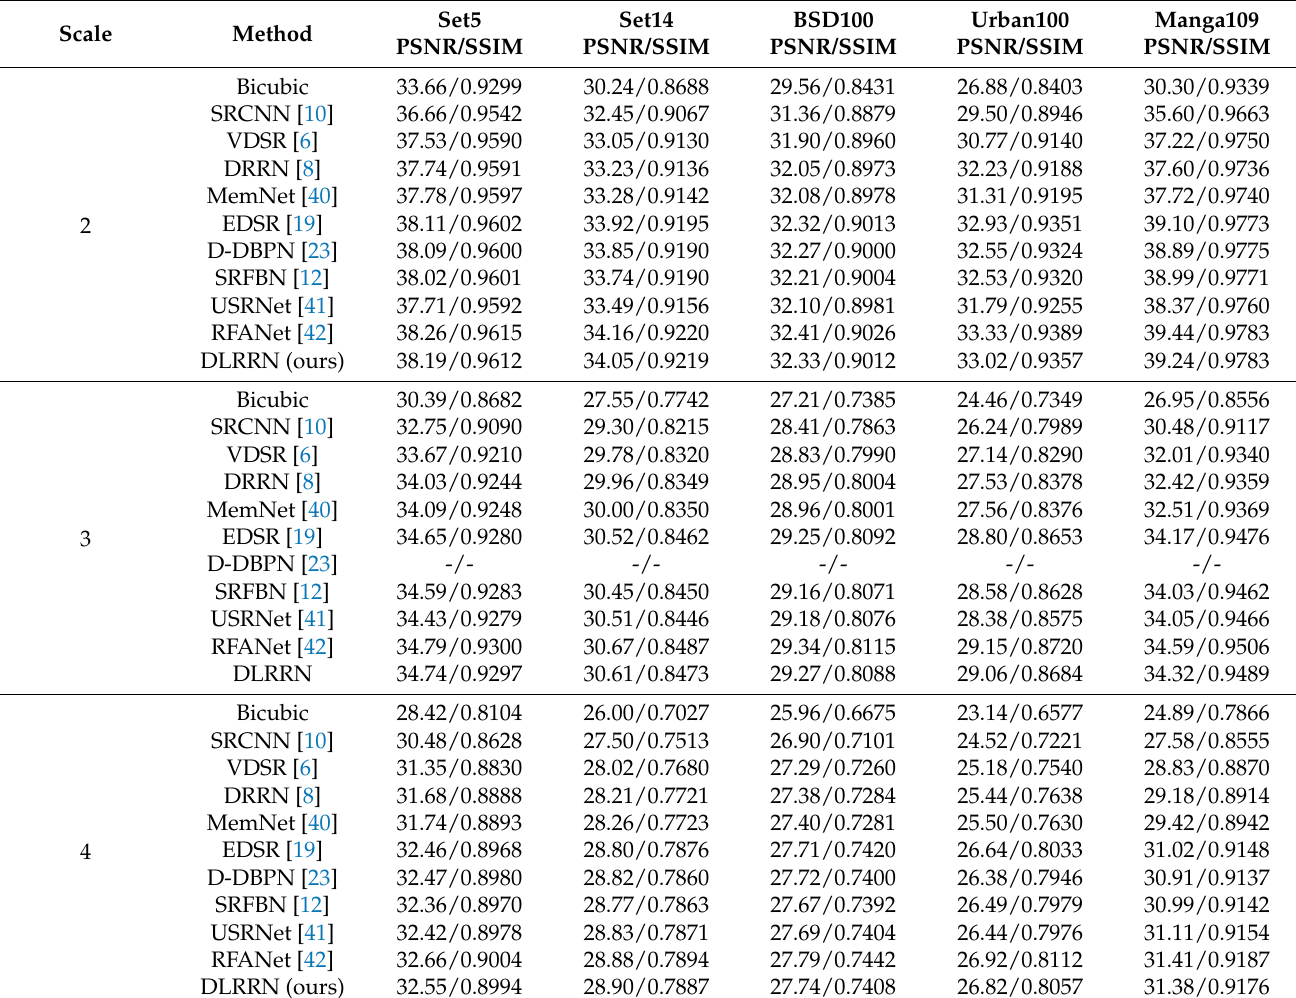
Table 6. Quantitative evaluation of comparative algorithms in BI degradation models. Red indicates the best SR reconstruction performance, and blue is the second